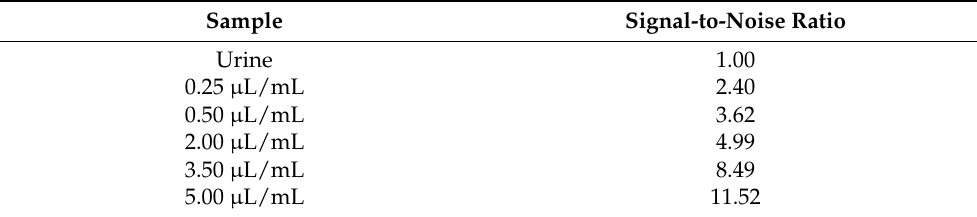
Figure 3. The LoD of ethanol in human urine using the droplet method was determined by visual evaluation. Table 1. The LoD of ethanol in human urine for the droplet method was determined based on the signal-to-noise ratio.